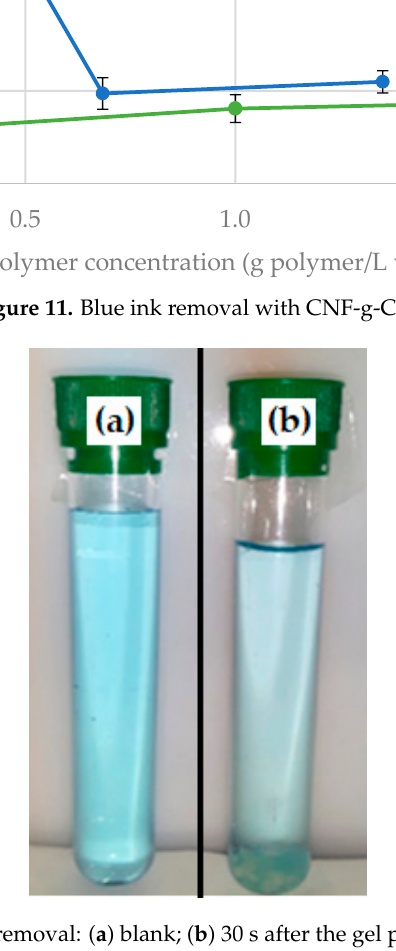
Figure 12. Blue ink removal: ( a ) blank; ( b ) 30 s after the gel polymer application.